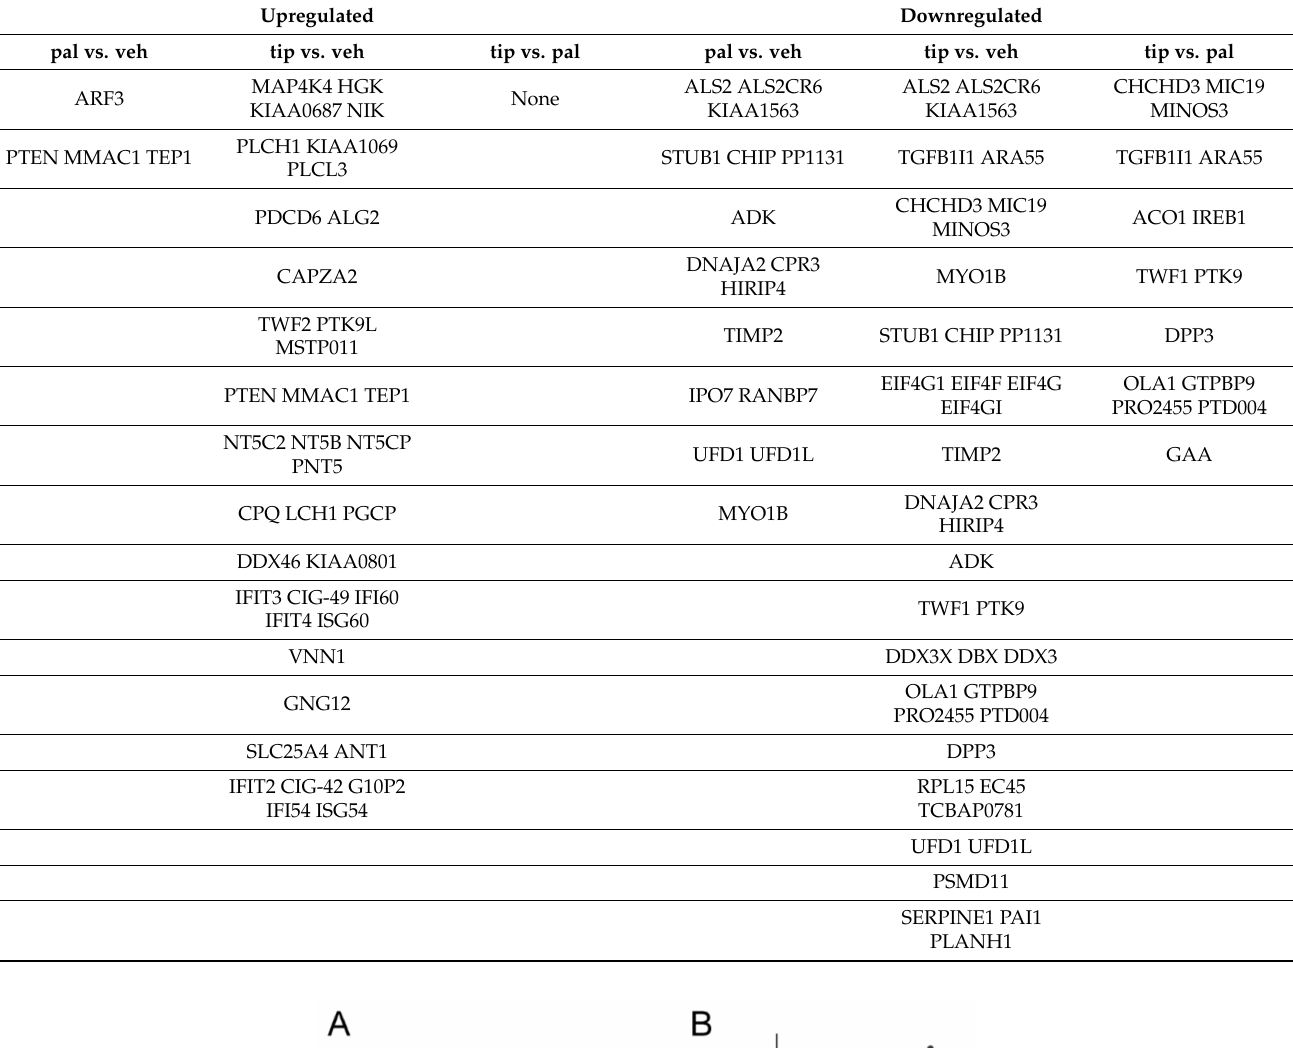
Table 2. Key proteins. List of hub proteins that were found in the differentially expressed proteins in each comparison.